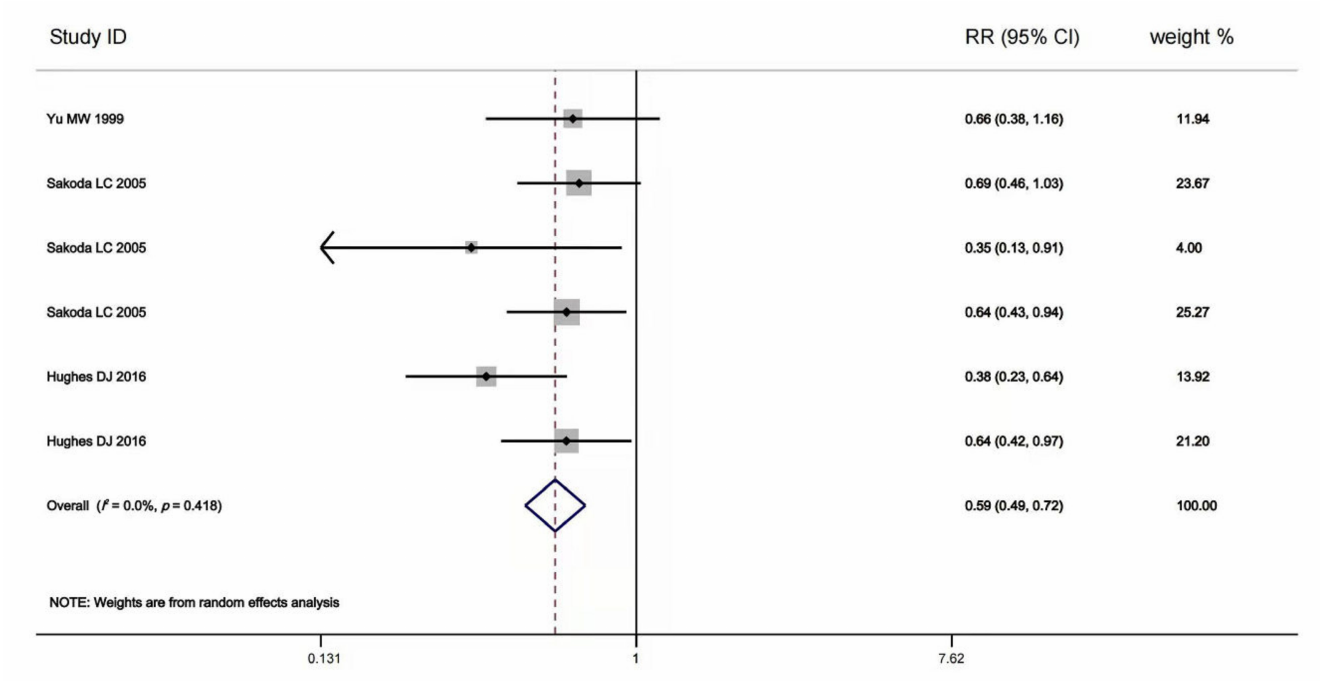
Figure 2. Forest plot of estimates comparing the elevated risk of advanced chronic liver diseases for the highest baseline selenium level compared to the lowest baseline selenium level [40,74,76]. The width of the black line represents 95% CI, which were obtained from a linear meta-regression without a constant using logarithmic RR for advanced chronic liver diseases as the dependent variable and the difference in selenium level to the study-specific reference group as the independent variable (either the highest baseline selenium level or the lowest baseline selenium level). The random-effects accounted for clustered variance in each